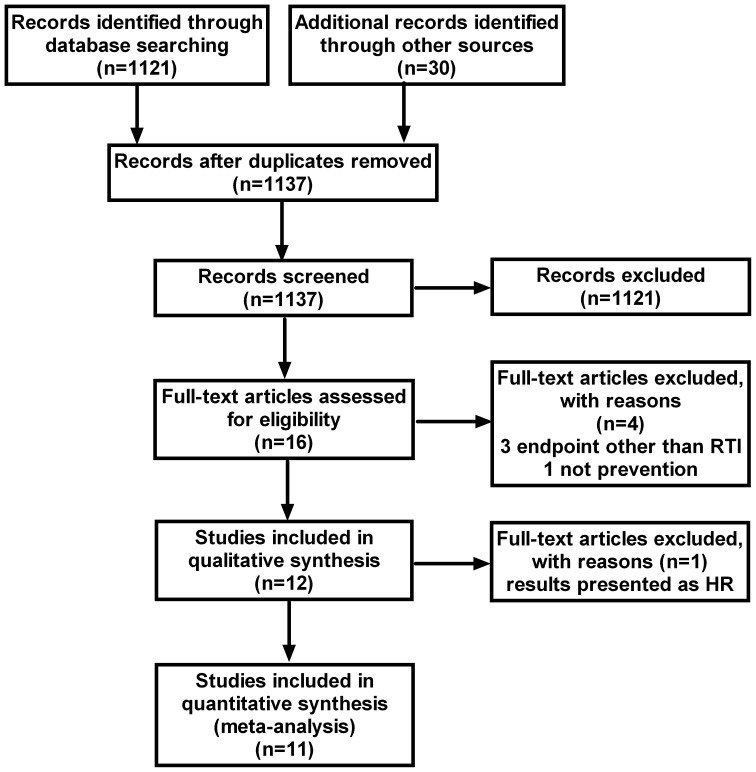
Flowchart for selection of eligible studies.